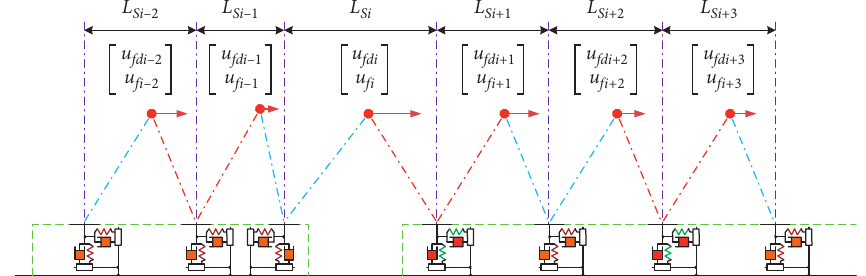
Figure 3: The variable step-length control strategy.